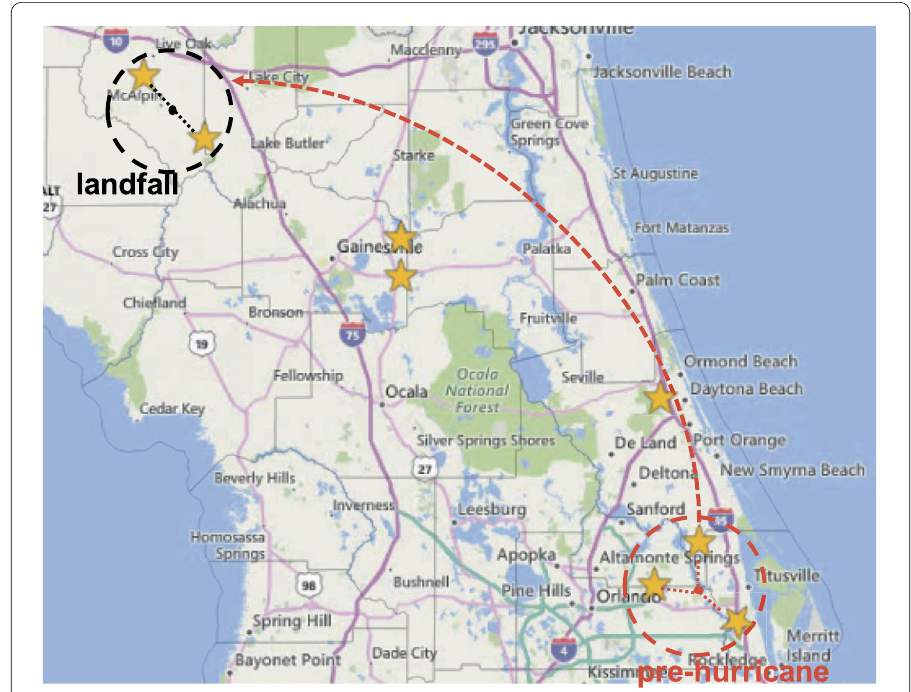
Figure 3 Identification of evacuation flows based on the geographic tweets of users at different phases